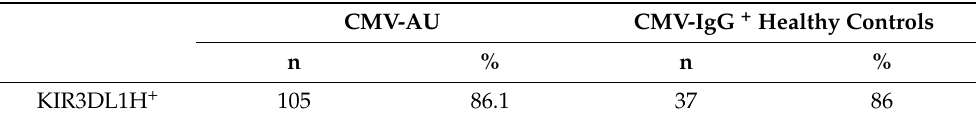
Table 4. Frequency of individuals carrying KIR3DL1H alleles in the CMV-AU and CMV-seropositive control